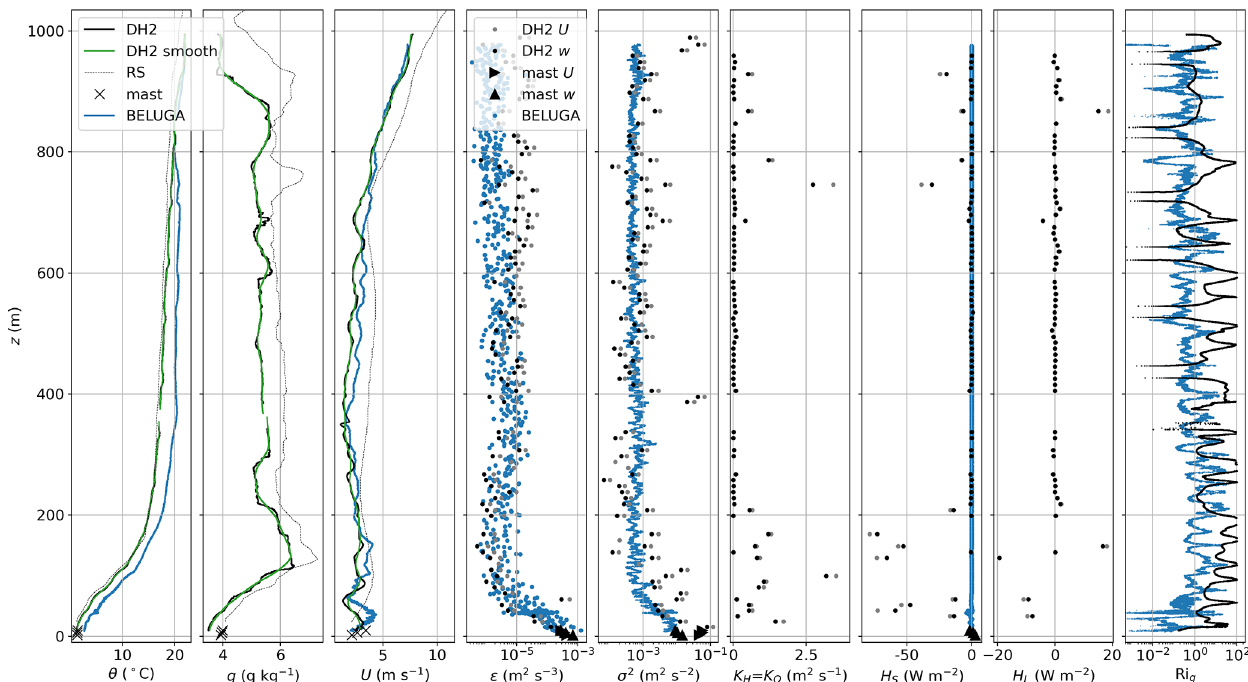
Figure 9. Vertical profiles for 26 July (first ascent) for DH2 (black lines and dots) and BELUGA (blue lines and dots) with radiosonde (thin dotted lines) and tower (crosses and triangles near the surface) measurements as reference. The panels show potential temperature θ , specific humidity q , horizontal wind speed u , dissipation rate ε , wind speed variance σ 2 , turbulent exchange coefficients K H and K Q , turbulent heat fluxes of sensible heat H S and latent heat H L , and gradient Richardson number Ri g . The green lines show the smoothed DH2 profiles for gradient calculations. The gray dots for ε , σ 2 , K , and flux values are derived from horizontal DH2 measurements without anisotropy